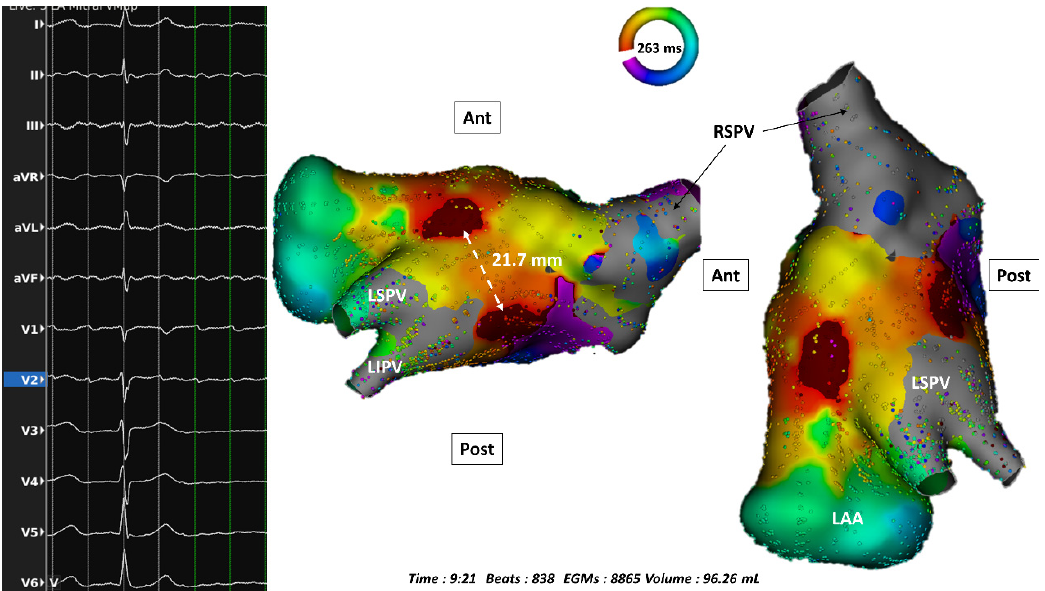
Figure 2. Ultra-high density electroanatomic activation map (during macroreentrant tachycardia) showing a rare case of endo-epicardial breakthrough at the level of a roof line created with radiofrequency delivery. LAA: left atrial appendage; RSPV: right superior pulmonary vein.